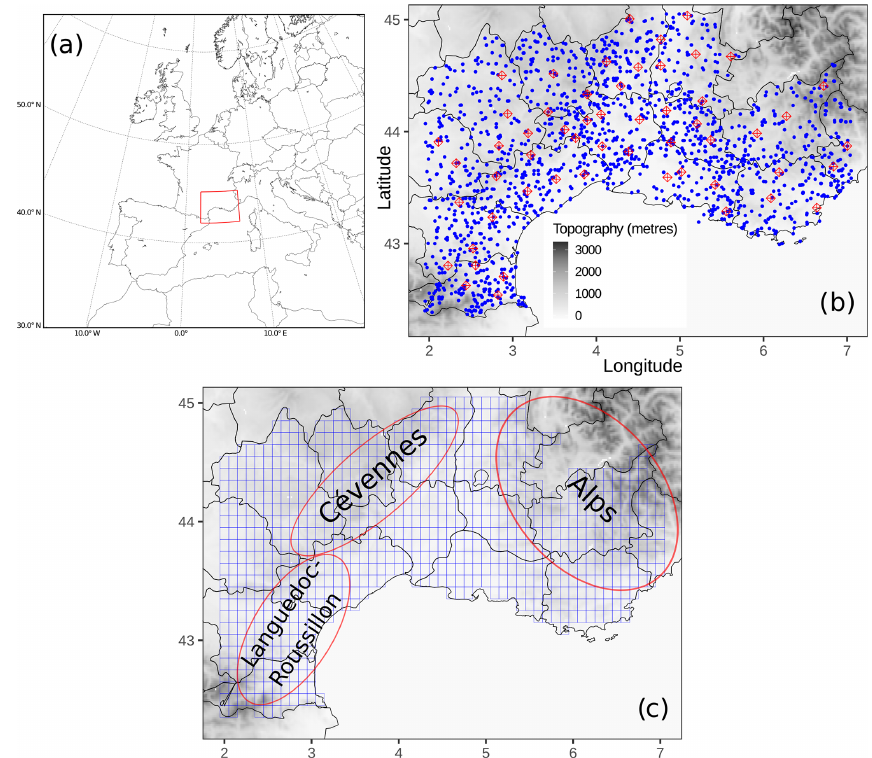
Figure 1. Panel (a) shows a situation map of the investigated area (rectangle with red edges) with respect to western Europe and the Mediterranean Sea. Panel (b) shows the rain-gauge network used for the study. Red diamonds represent the rain gauges selected for cross- validation testing, and blue dots represent the rain gauges selected for cross-validation training. Panel (c) shows the 0 . 1 ◦ × 0 . 1 ◦ model grid (in blue), along with the location of three key areas. Domain D is located within the borders of the model grid (c) . Table 1. Physical parameterizations used in the ensemble reforecast. Turbulence Shallow convection Deep convection Oceanic